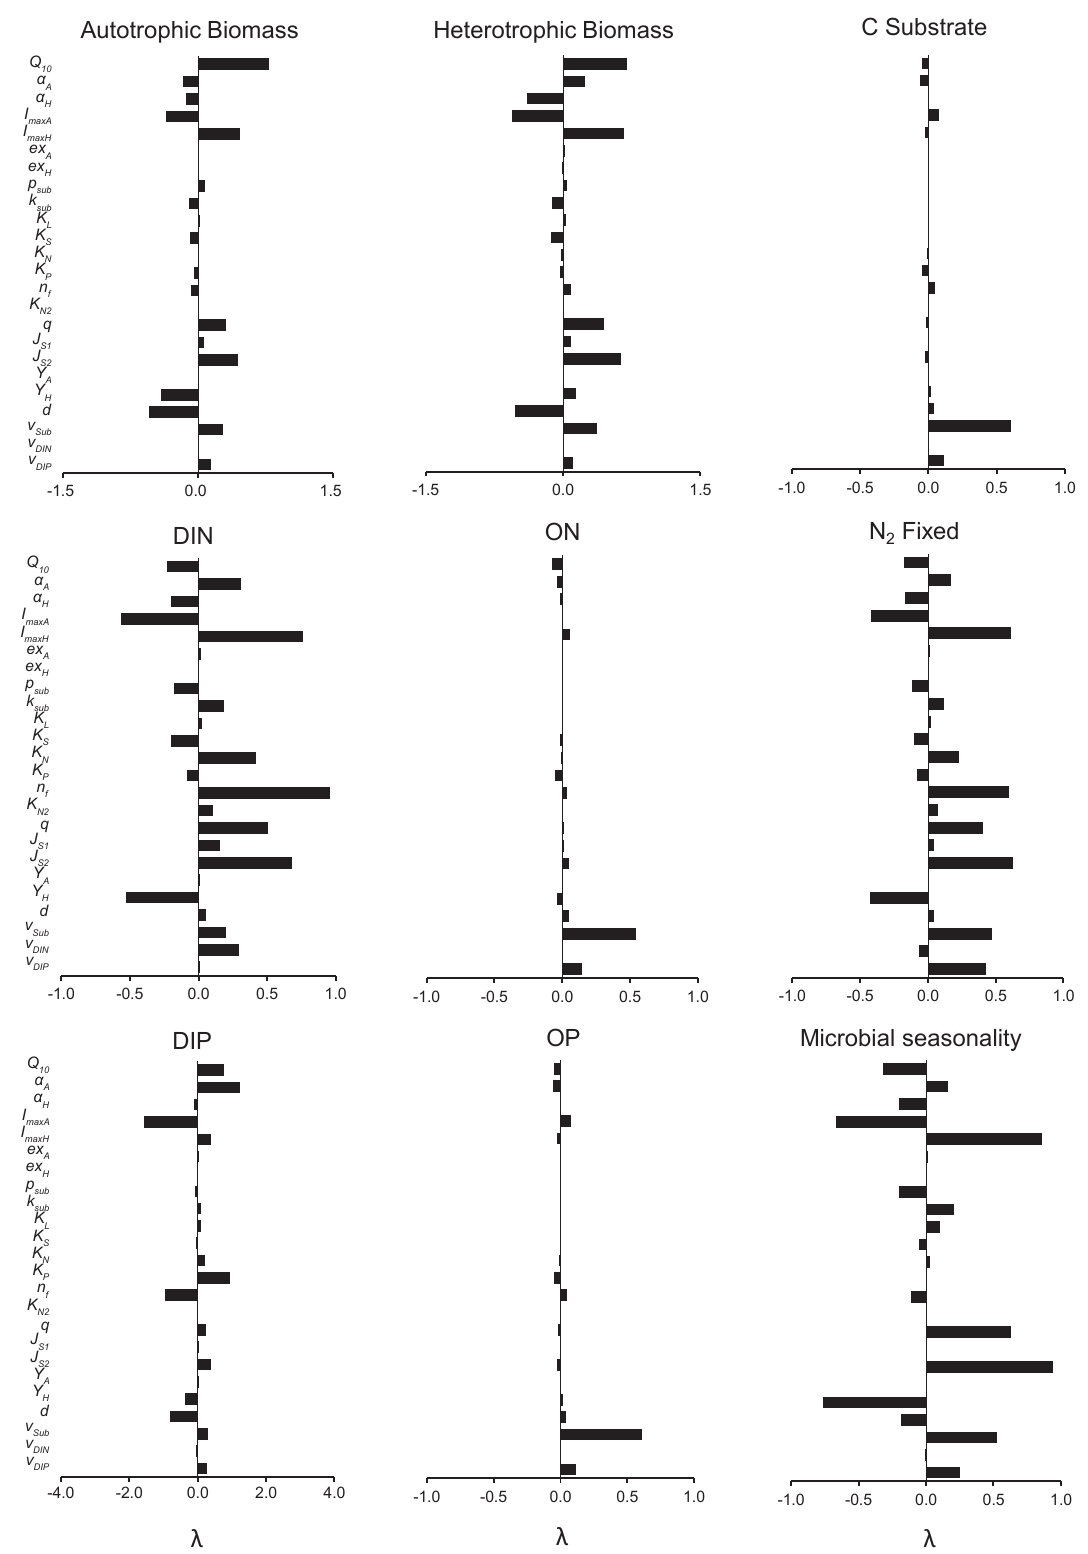
Figure 8. Sensitivity of model outputs ( λ) to individual parameter variation. The model is forced with meteorological data from the Damma Glacier (Fig. 4) over 75